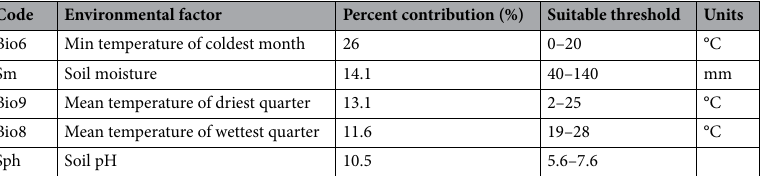
Table 1. Contributions and thresholds of the major environmental factors in the MaxEnt models for the current suitable habitat of Sapindus